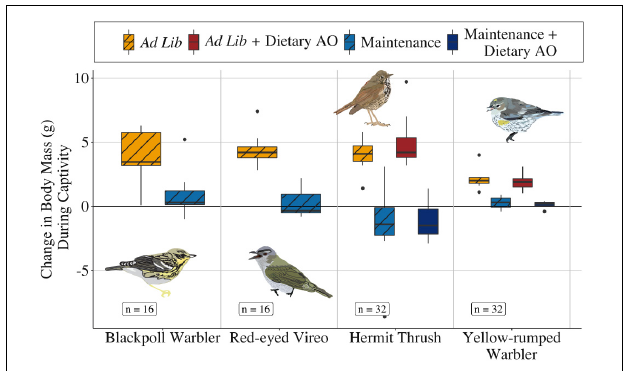
FIGURE 2 | Change in body mass (g) during the ca. 3 days in captivity for Blackpoll Warblers and Red-eyed Vireos given ad lib food (gold with diagonal stripes) or maintenance amounts of food (light blue with diagonal stripes), and Hermit Thrushes and Yellow-rumped Warblers given ad lib food without and with supplemental antioxidants (gold with diagonal stripes and solid dark red, respectively) or maintenance amounts of food without and with supplemental antioxidants (light blue with diagonal stripes and solid dark blue, respectively). Boxes represent 95% confidence intervals; whiskers represent 1.5 times the interquartile range and outliers are represented by black dots. Labels indicate samples sizes for each species.